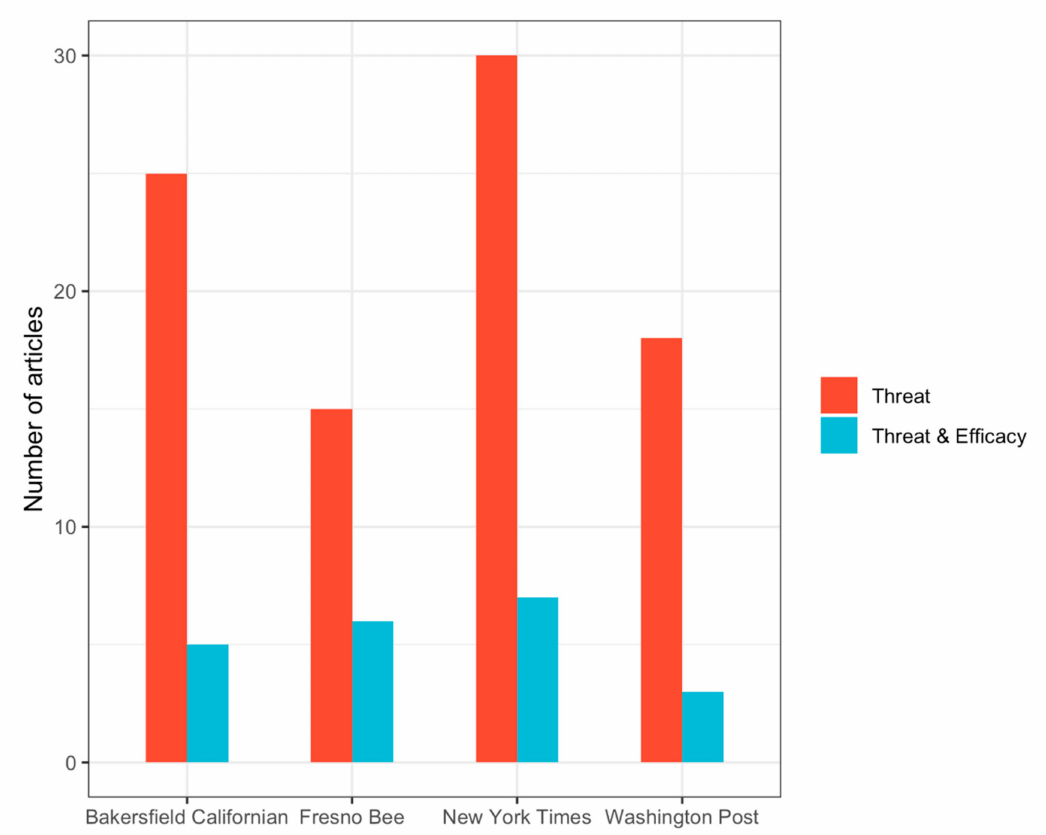
Figure 1. Threat and e ffi cacy information per